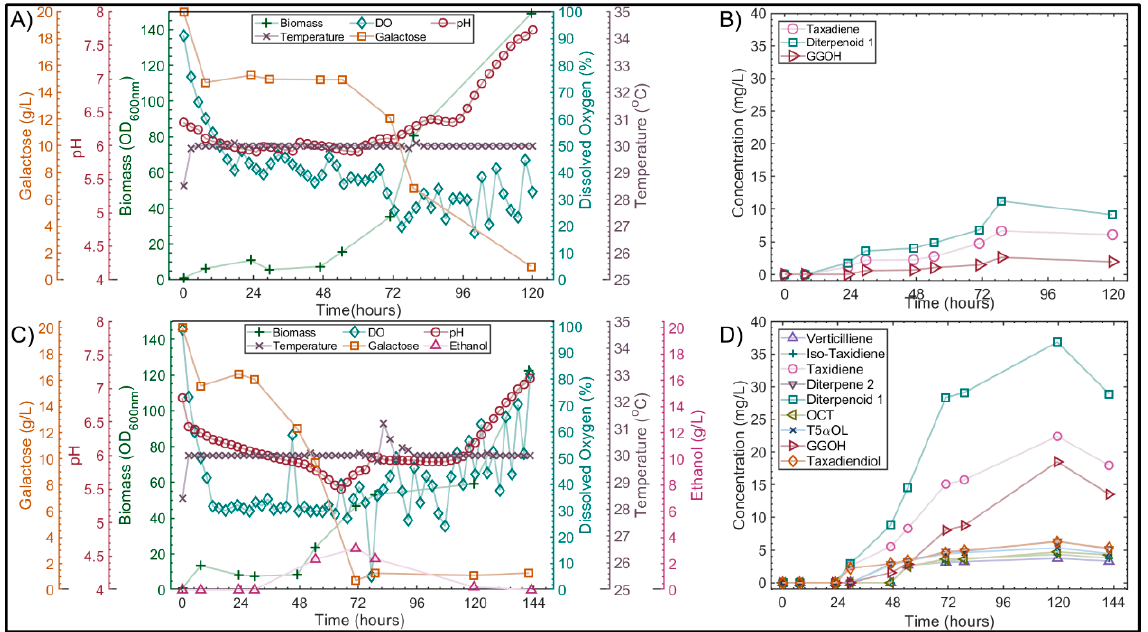
Figure 3. The 2 × P and 2 × YP bioreactor cultivation results. The initial concentration of peptone (2 × P) and both yeast extract and peptone (2 × YP) in the YPG media were doubled in LRS6 cultivations. Temperature (x), pH (o) and dissolved oxygen ( ⋄) were monitored and controlled online. Biomass (+), galactose ( □) and ethanol ( ∆) concentration were monitored via offline sampling twice daily for 2 × P ( A ) and 2 × YP ( C ) cultivations. The taxane concentration was measured via the GCMS analysis of dodecane samples taken twice daily for 2 × P ( B ) and 2 × YP ( D ).